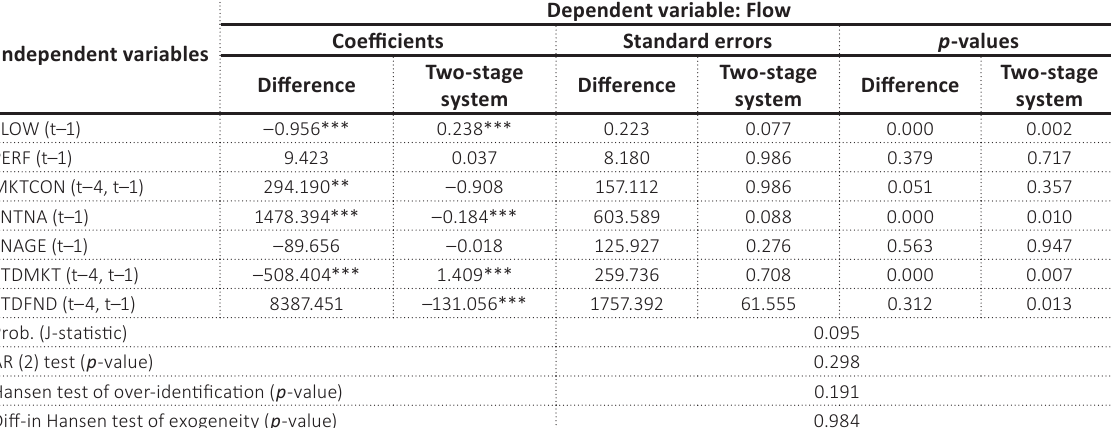
Table 3. GMM results of flow-performance dynamics under different market